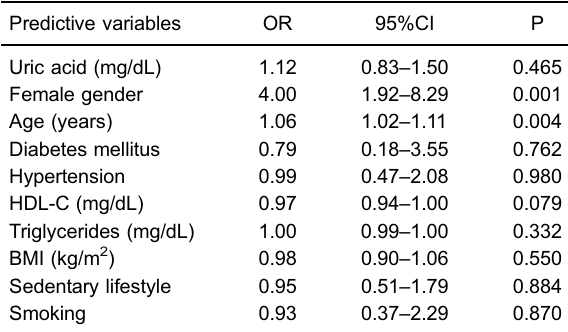
protein cholesterol; BMI: body mass index.